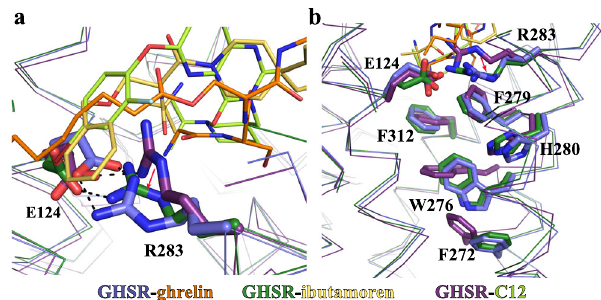
Fig. 4 Conformational changes of critical motifs near the agonist-binding pocket. a Different conformations of the E124-R283 salt bridge in the active structures of GHSR with ghrelin and ibutamoren and the inactive structure of GHSR with C12. The salt bridge interactions are shown as dashed lines. b Rearrangement of the aromatic cluster residues W276, F279, H280, and F312 in the active and inactive GHSR. Two active GHSR and the inactive GHSR structures are colored in blue, green, and purple, respectively. Ghrelin, ibutamoren, and C12 are shown as orange, yellow and lemon sticks, respectively.